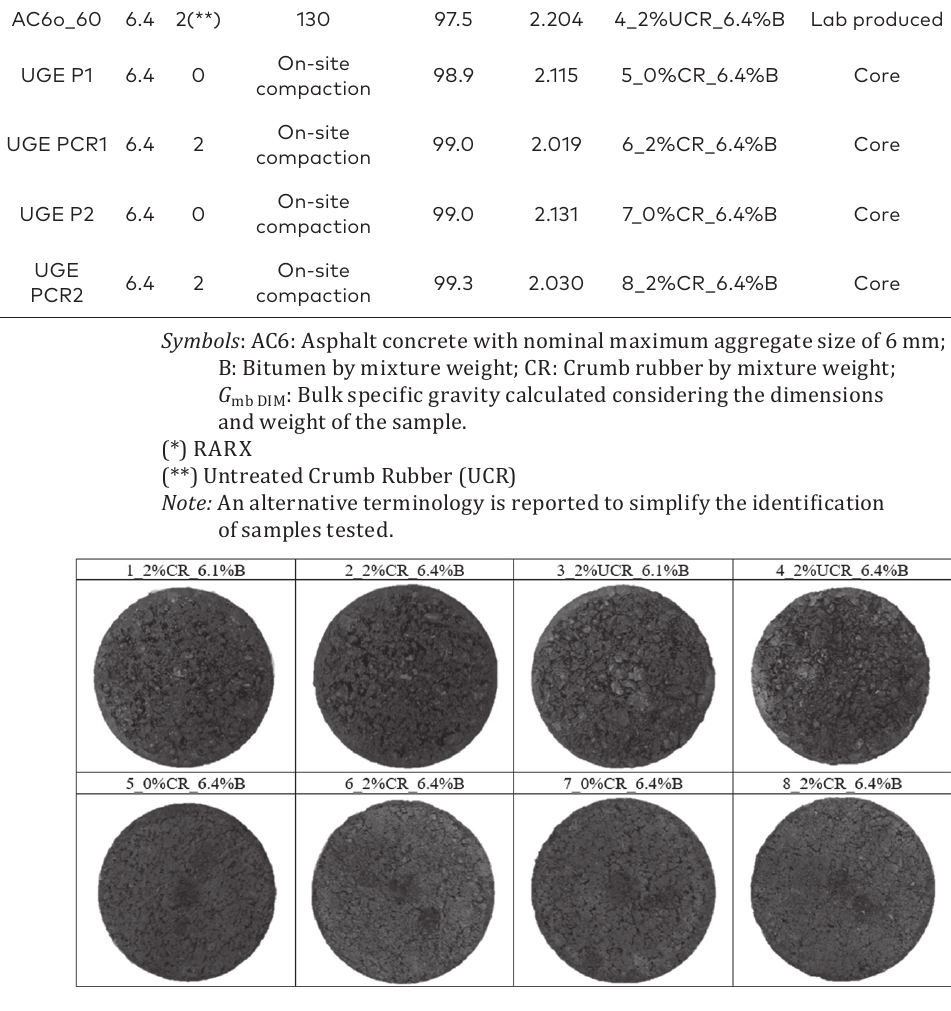
Figure 6. Upper surface of the tested